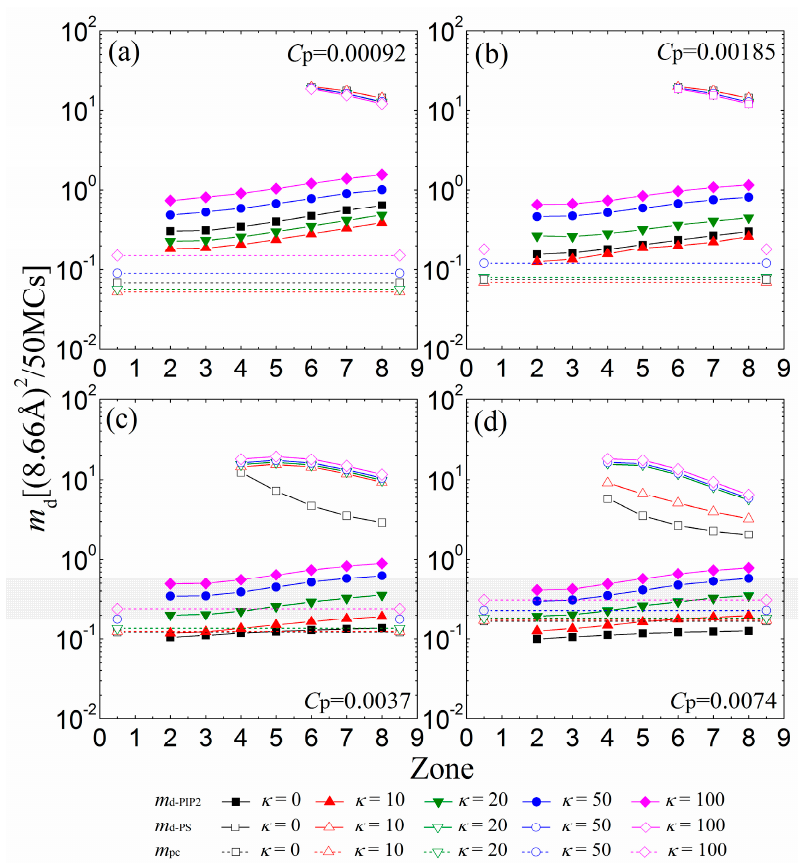
Figure 6. MSD of the center of mass of the sequestered PIP 2 micro-domains ( m d-PIP2 , solid symbols and solid lines) and PS micro-domains ( m d-PS , vacant symbols and solid lines) calculated in every 50 MC steps for various chain rigidity parameters κ for ( a ) C p = 0.00092; ( b ) C p = 0.00185; ( c ) C p = 0.0037; and ( d ) C p = 0.0074. Vacant symbols with dashed lines indicate m pc of the anchored polymers. The results shown are for PC:PS:PIP 2 = 98:1:1.